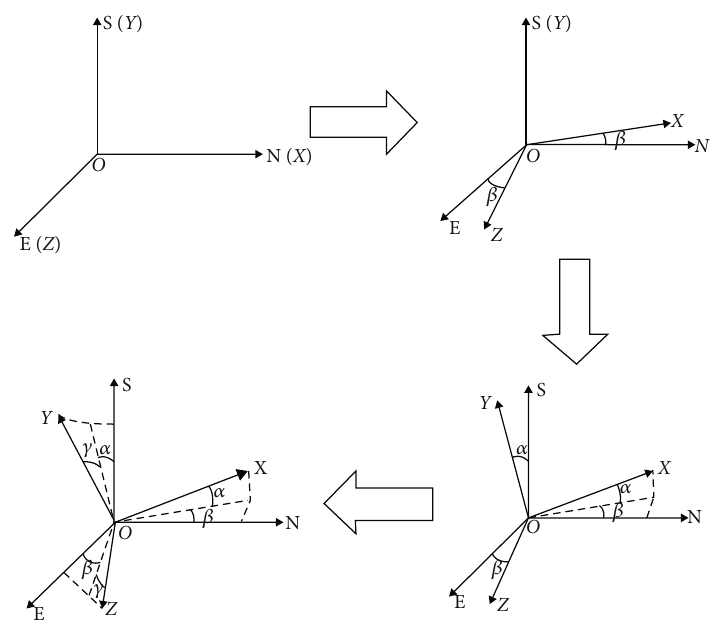
Figure 2: Schematic diagram of transformation between coordinate